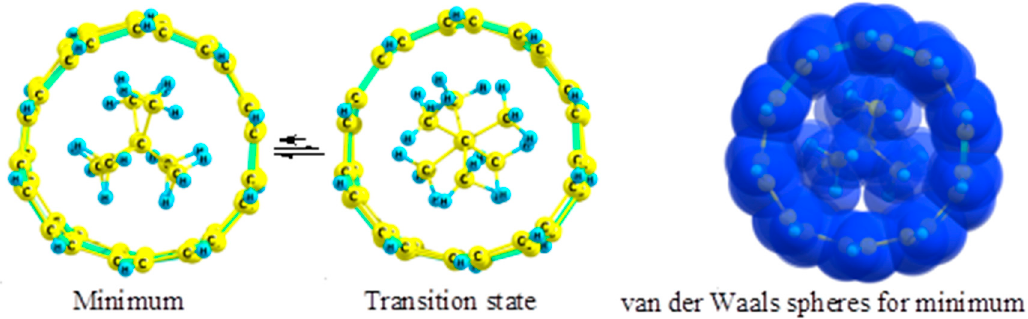
Figure 4. Conformational equilibrium in cluster C 8 H 18 @(5,5). Adapted with modification [134].